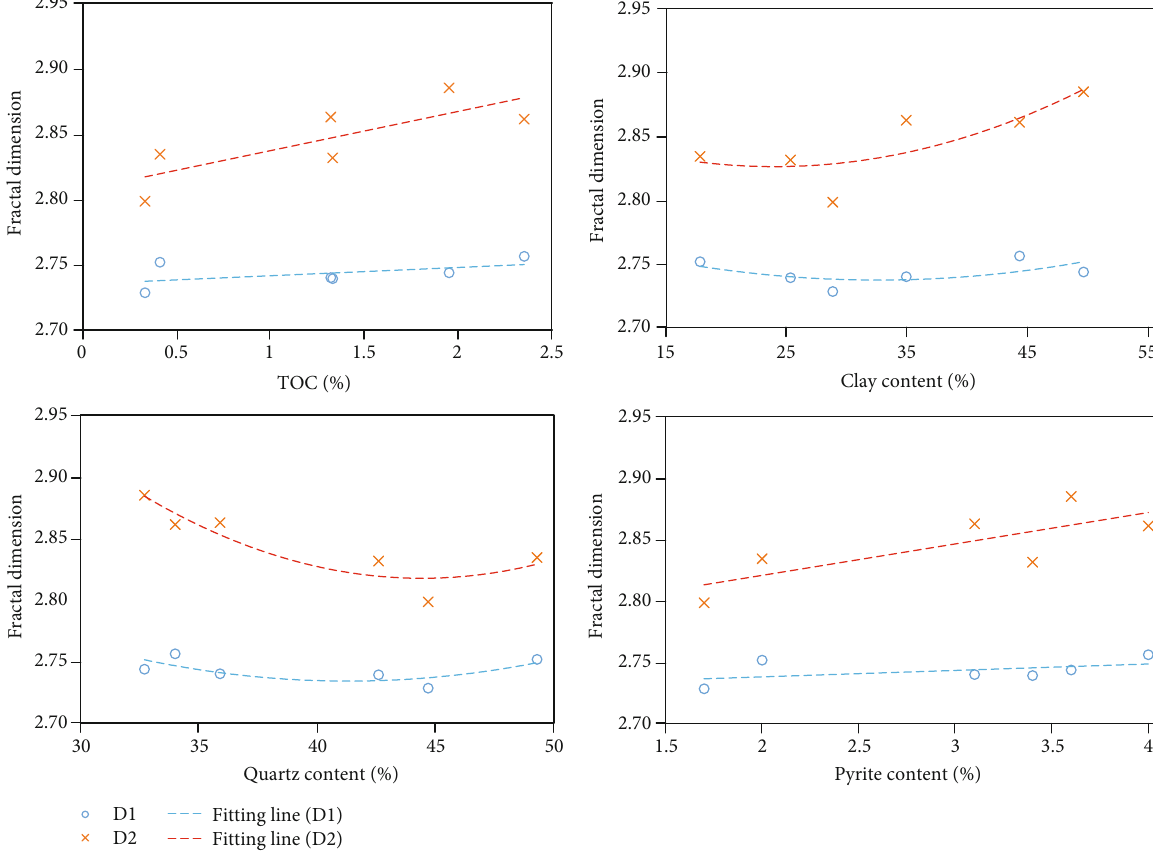
Figure 11: Main controlling factors of pore